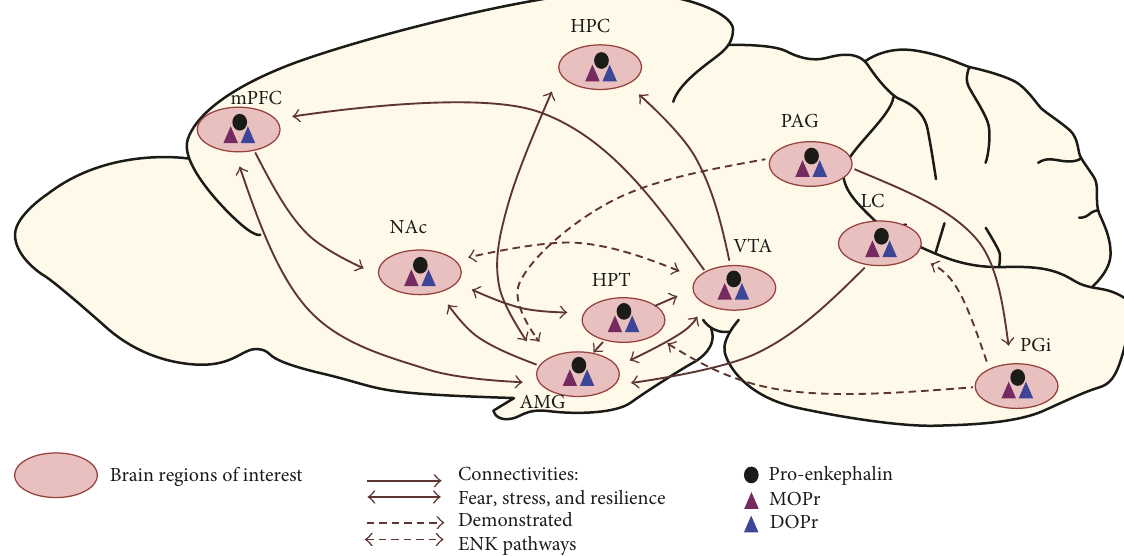
Figure 1: Cartography of main connectivities involved in fear, stress, and resilience, as well as demonstrated ENK pathways between areas and expression of ENK, MOPr, and DOPr. Pink circles represent brain regions of interest. Full arrows correspond to circuitries of stress, fear, and resilience. Dotted arrows represent demonstrated ENK circuitries. The black dot corresponds to expression of pro-enkephalin, and purple and blue triangles correspond to MOPr and DOPr expression, respectively. AMG: amygdala; HPC: hippocampus; HPT: hypothalamus; LC: locus ceruleus; mPFC: medial prefrontal cortex; NAc: nucleus accumbens; PAG: periaqueducal grey; PGi: paragigantocellularis nucleus; VTA: ventral tegmental